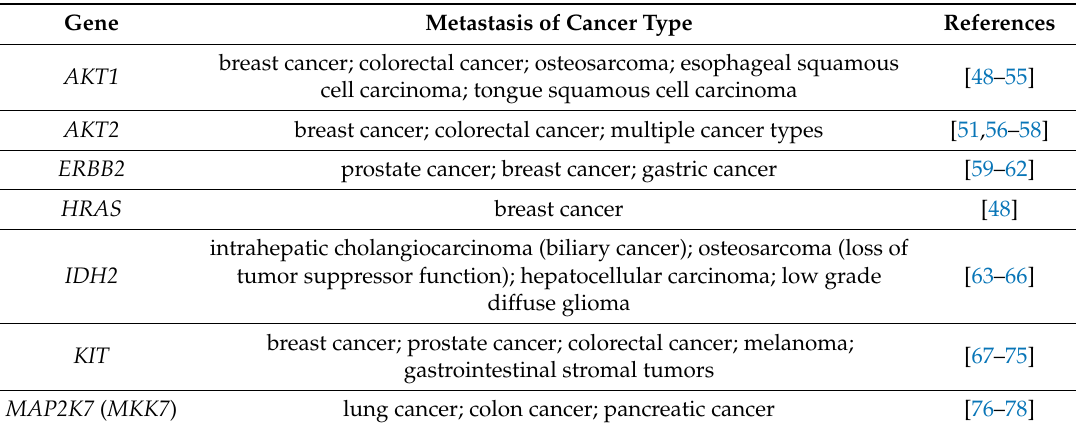
Table 1. Examples of cancer driver genes implicated in development of metastatic disease in multiple types of human malignancies, expression of which was significantly repressed by P-bi-TAT. References cited report clinical and experimental evidence linking these genes with development of metastasis in patients diagnosed with different cancer